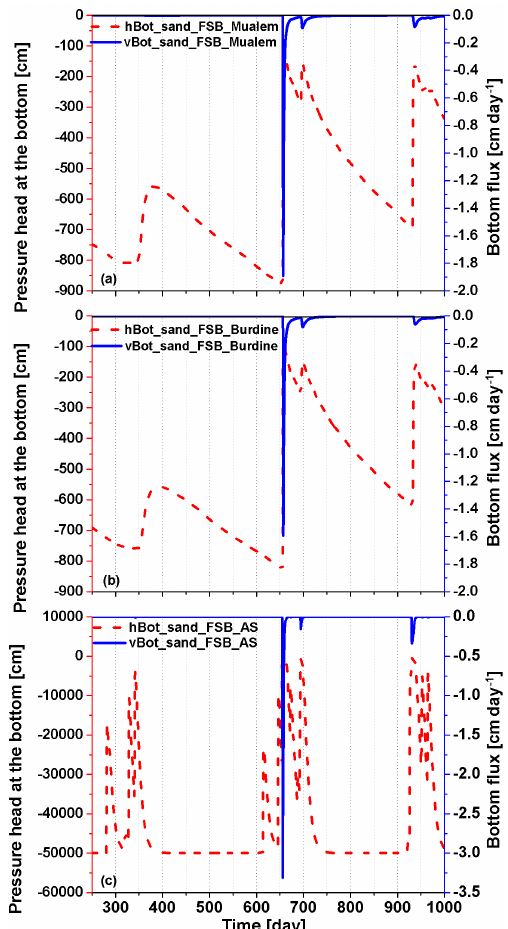
Figure 10. Pressure head hBot and flux density vBot at the bot- tom of the sand column for the FSB parameterization (see Ta- ble 1) and the conductivity functions of Mualem (1976) (a) , Bur- dine (1953) (b) , and Alexander and Skaggs (1986) (c) .